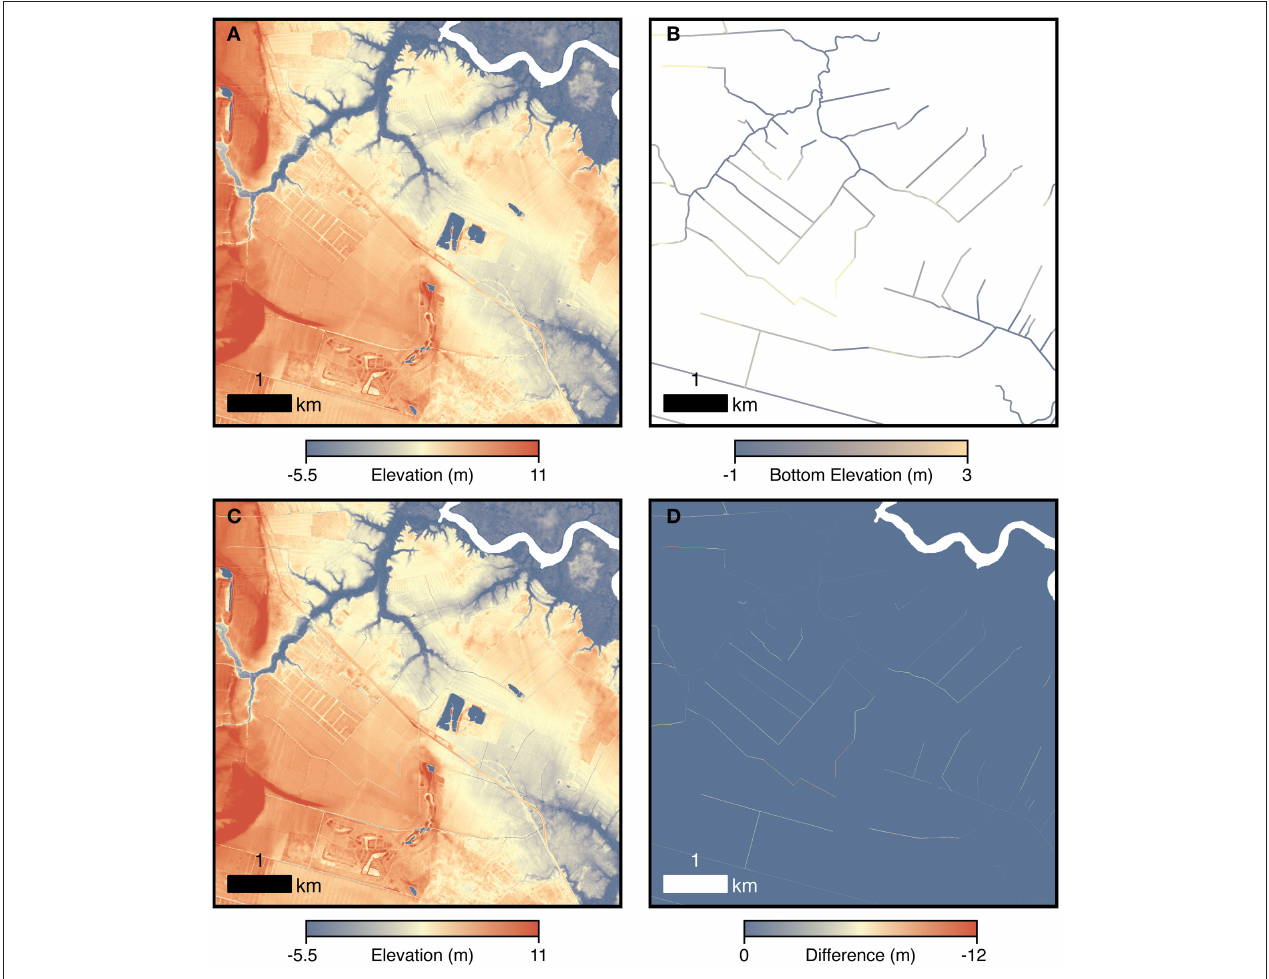
FIGURE 4 | Illustration of pre- and post-hydrologic correction with inset (A) original DEM, (B) extracted stream and ditch line network as minimum point cloud buffer calculations attributed to raster cells, (C) hydro-conditioned DEM, and (D) elevation differences in the ditch